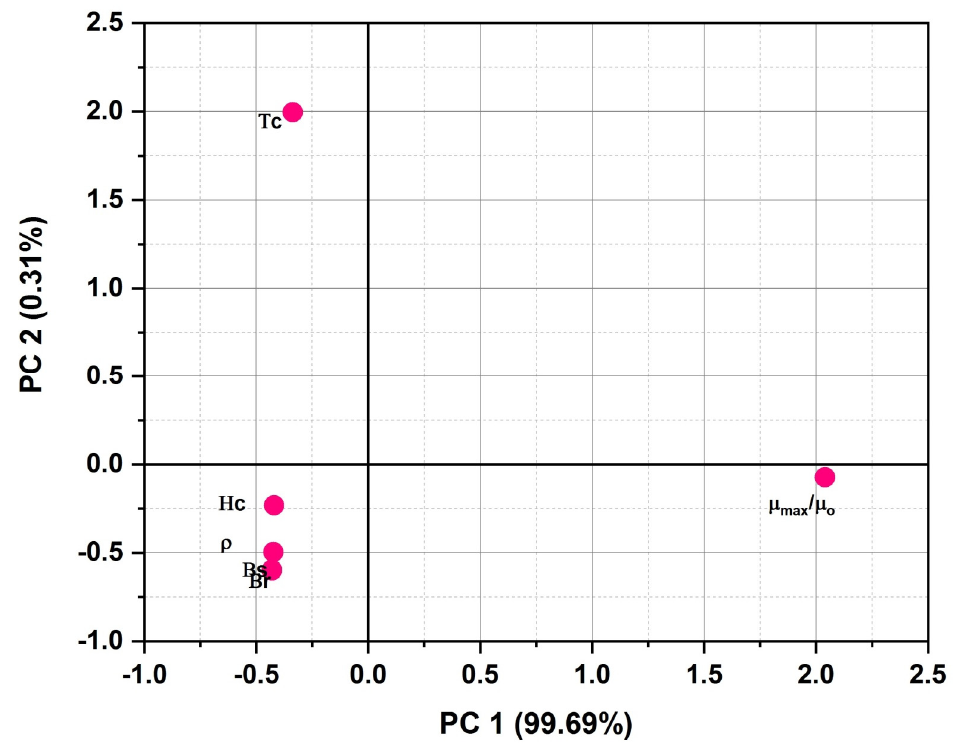
Figure 6. PCA plot of magnetic characteristics on the first two PCs